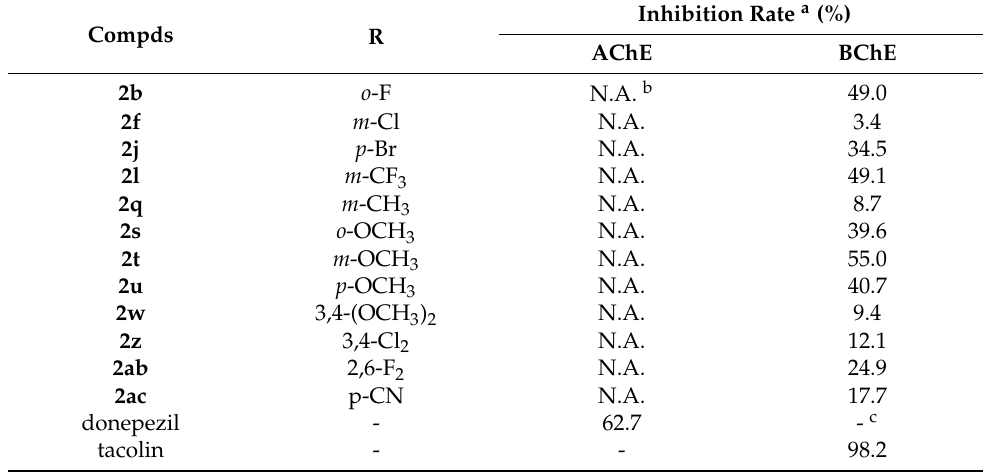
Table 2. Inhibitory activity (%) of part compounds against AChE and